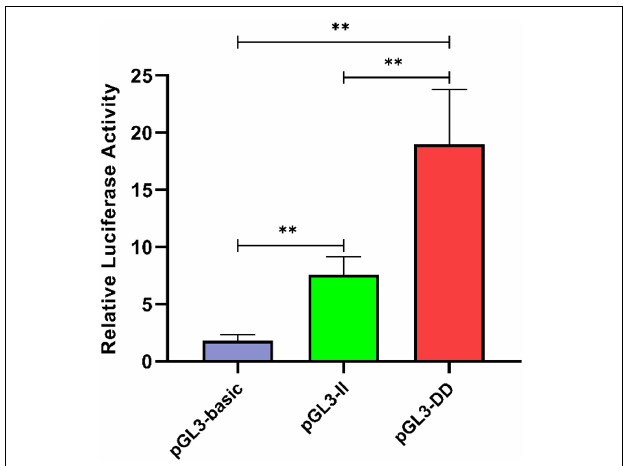
FIGURE 8 | Luciferase activity in DF-1 cells transfected with recombinant plasmids. Data are presented as the means ± SD ( n = 6 samples of each plasmid). ∗∗ P < 0.01, very significant difference.